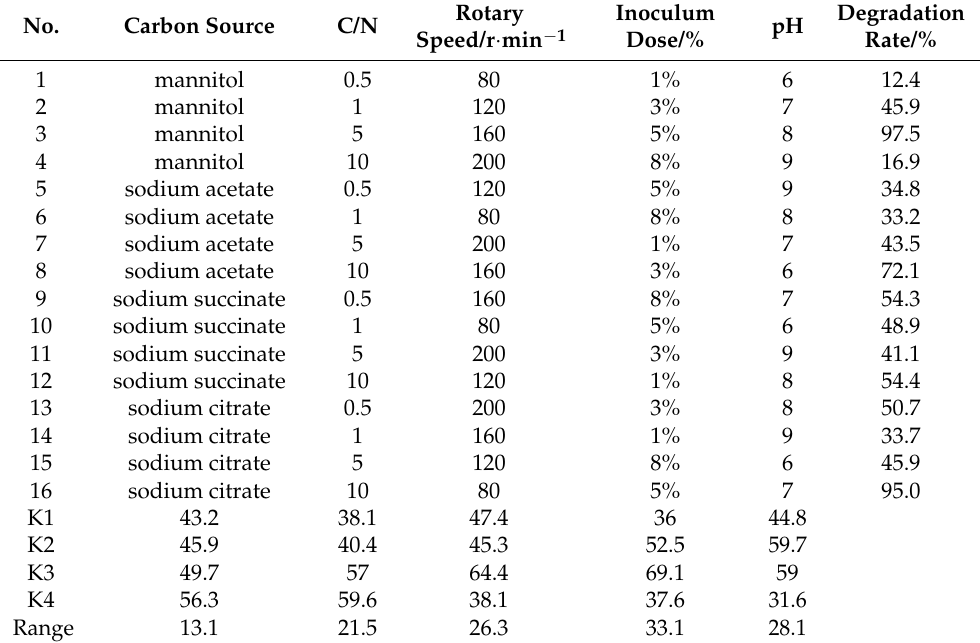
Table 3. The orthogonal test